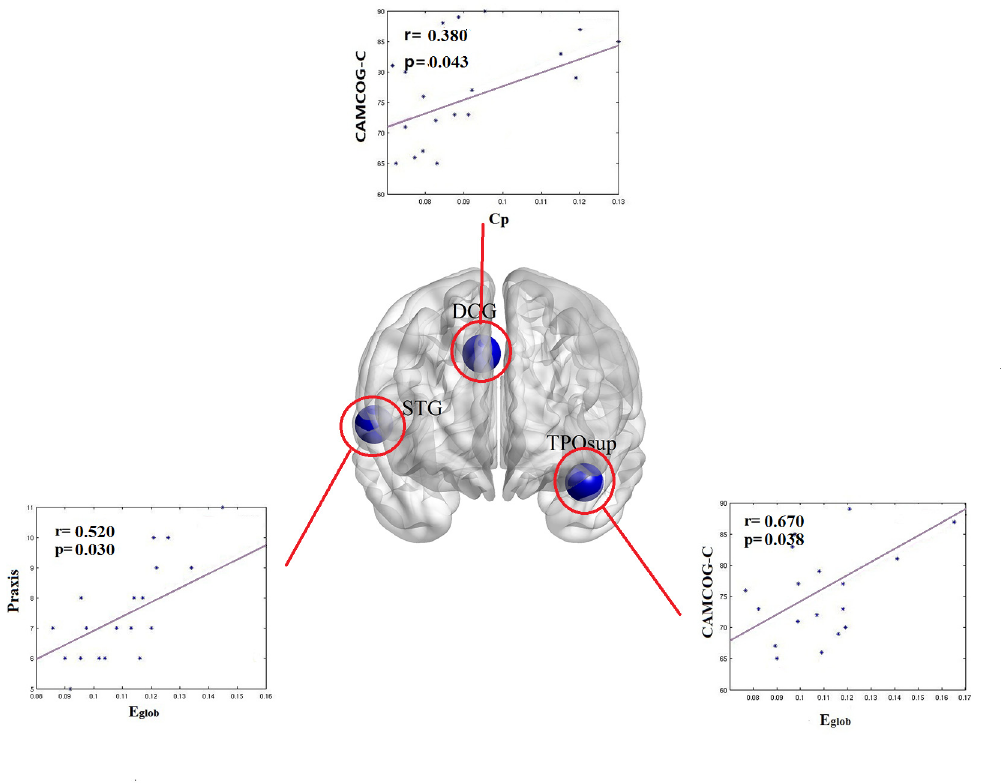
Fig 3. The relationship between global network/nodal characteristics and CAMCOG-C scores/ of the praxis functional score patients with SVCI. CAMCOG-C:Cambridge cognitive examination-Chinese version. Cp = clustering coefficient; E glob = global